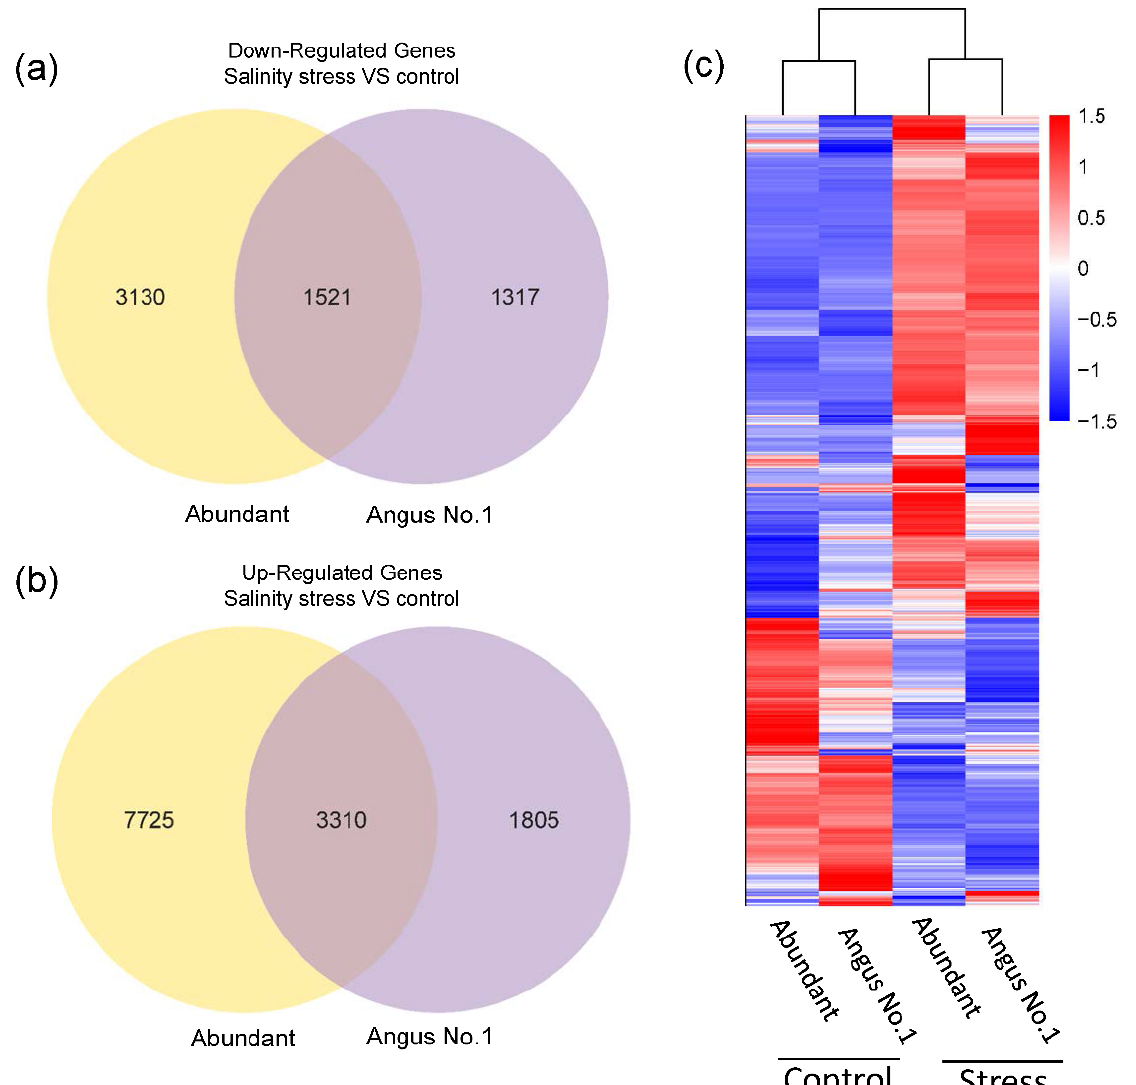
Figure 5. Comparison of differentially expressed genes in stress-tolerant and sensitive cultivars; ( a ) overlaps of down-regulated genes between cultivars Abundant and Angus No. 1 during salinity stress; ( b ) overlaps of up-regulated genes between cultivars Abundant and Angus No. 1 during salinity stress; and ( c ) clustering results of all DEGs in two cultivars that show cluster patterns of treatment conditions.